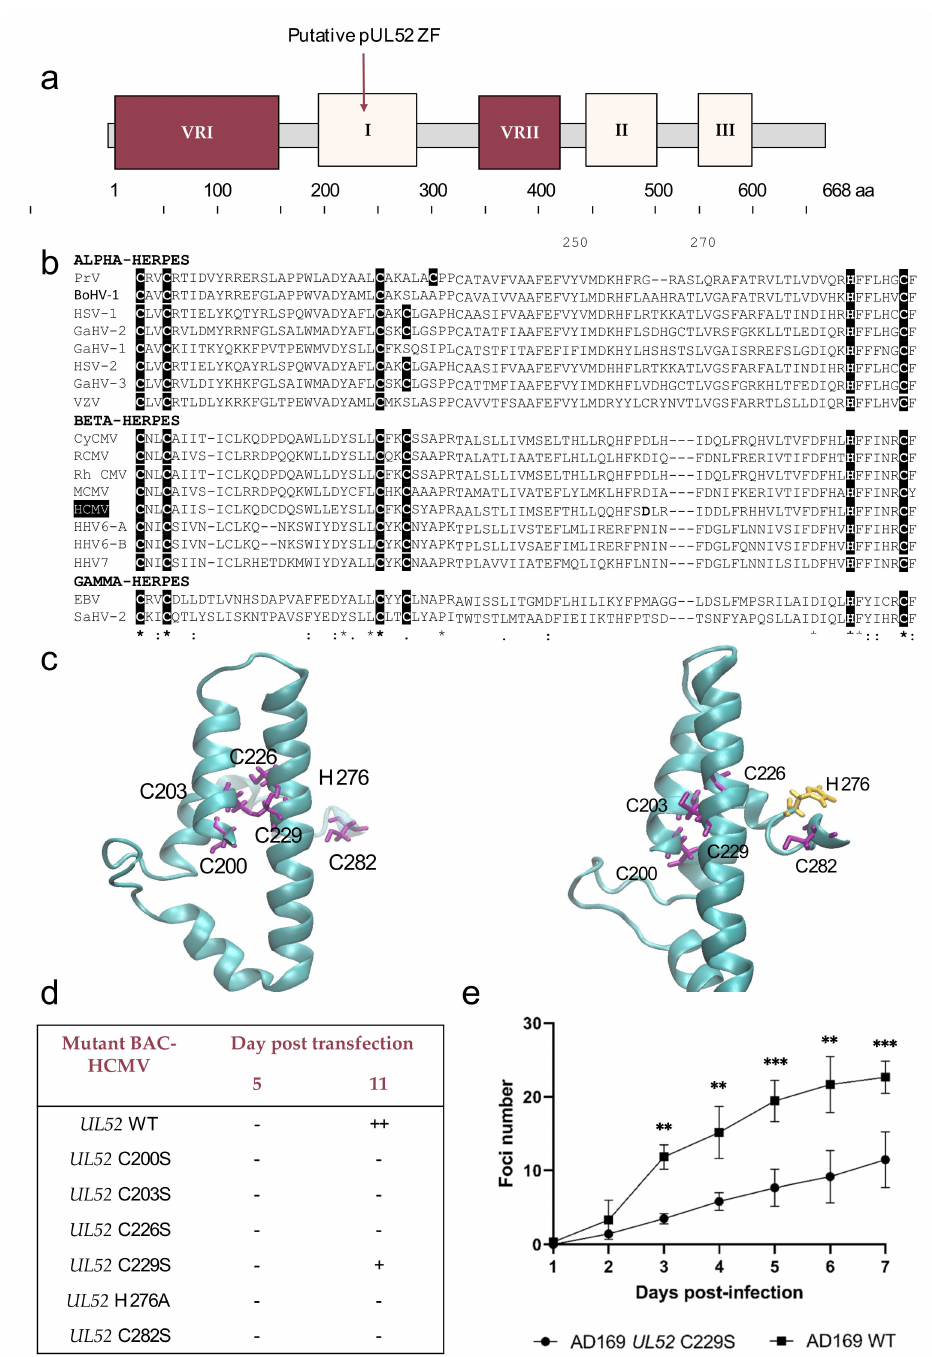
Figure 3. Identification of a putative zinc-finger motif within pUL52 protein. ( a ) Structure of HCMV pUL52 with a putative zinc-finger (ZF) pattern (VRI and VRII: variable regions I and II). ( b ) Sequence alignment of the conserved region I from 18 herpesviruses and residues involved in a metal-binding site. Sequence numbering is consistent with that of HCMV reference strain AD169 residues. Key residues involved in the formation of the zinc-finger motif are shown as white letters on black background. ( c ) The region I was extracted from the pUL52 theoretical structure. Cysteines are represented in purple, histidine H276 in yellow. ( d ) Impact of HCMV-BAC- UL52 mutants on growth in cell culture at day 11 (fibroblasts MRC-5). ( e ) Growth curves of the recombinant virus strain HCMV-BAC- UL52 -C229S in comparison to the parental strain HCMV- BAC AD169 WT. Fluorescent foci were counted daily from day 1 to day 7. Curves are the average of three independent experiments. ** p < 0.01; *** p < 0.001 (Mann–Whitney test). VRI and VRII: variable regions I and II. aa: amino